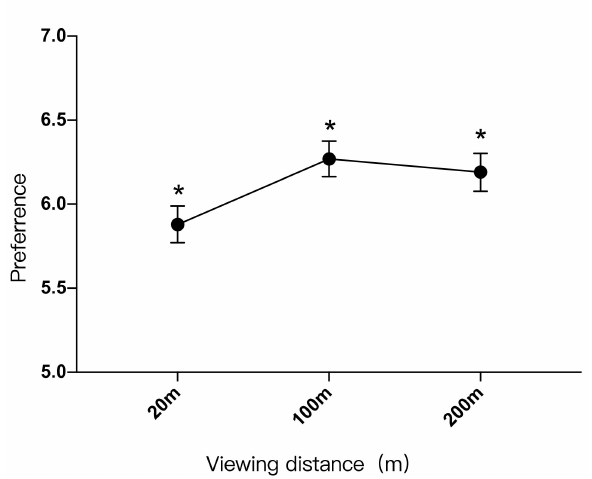
Figure 5. Impacts of different viewing distances on perceived preference, *: p <